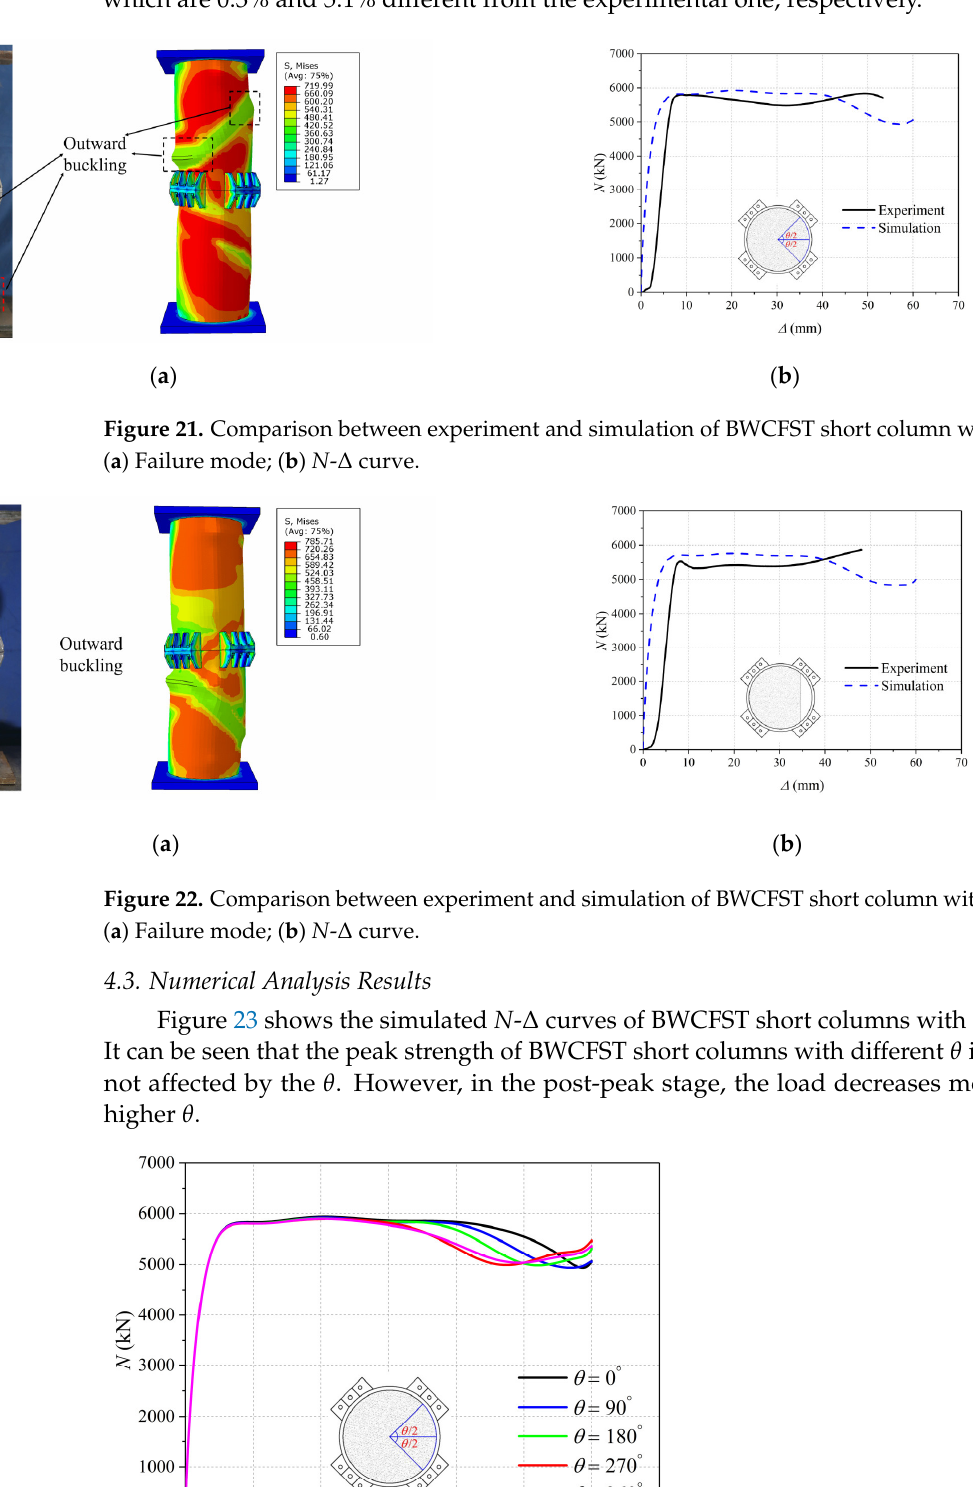
( e ) Figure 24. Simulated failure modes of BWCFST short column specimens with interfacial gap of dif- ferent  : ( a )  = 0°; ( b )  = 90°; ( c )  = 180°; ( d )  = 270°; ( e )  = 360°. The cross-section at the middle height of the BWCFST short columns is selected for the analysis of interaction stress ( p ) between the steel tube and core concrete at the peak strength. The distributions of longitudinal stress (S33) of core concrete and the p at the interface of core concrete of BWCFST short columns with different  are presented in Figure 25. For a continuous CFST short column [8], the highest value of S33 is displayed at the center of the cross-section, and the value of S33 is smaller at the position with a